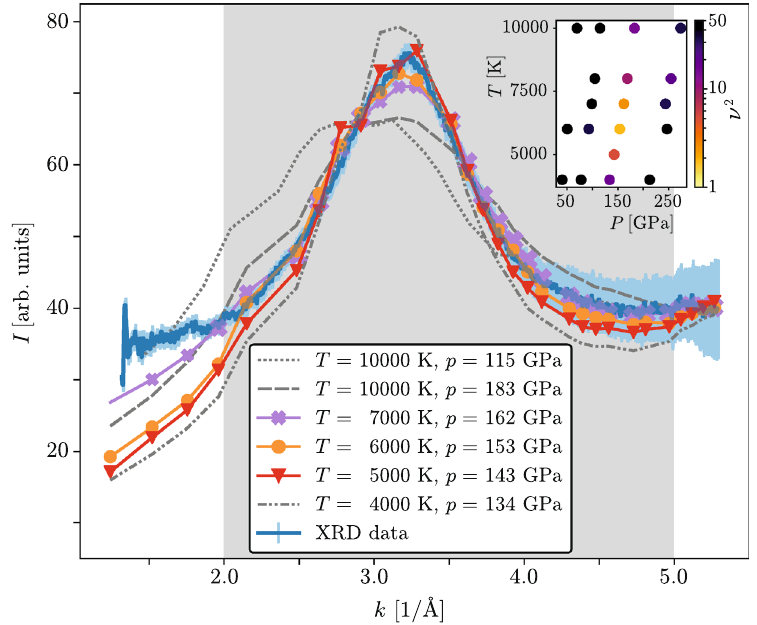
Figure 3. Comparison of the X-ray diffraction line-outs at the shock breakout to predictions made using density functional theory and molecular dynamics calculations. The gray region marks the k interval in that the simulations are fitted to the measurement. In the small plot, squared-deviations ν 2 (see Eq. (2)) are plotted for different simulation parameters. The coloured lines (representing T P 153 GPa and T 5000 K at P 143 GPa ) fit the experimental data = = =